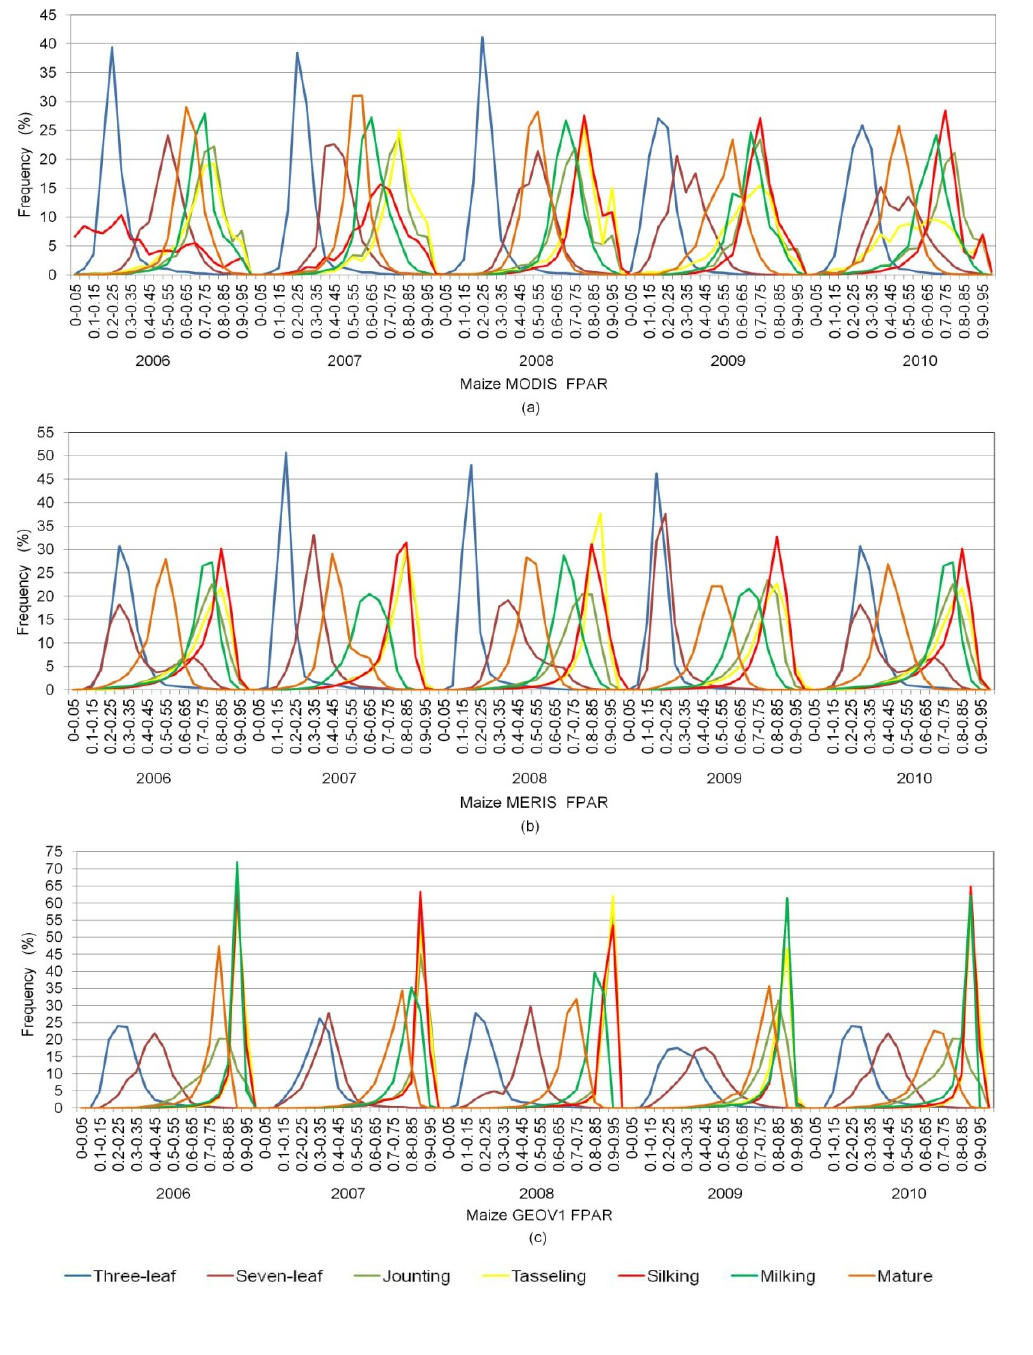
Figure 4. Maize and winter wheat FPAR frequencies of MODIS, MERIS and GEOV1 in different growth stages. ( a ) Maize MODIS FPAR; ( b ) Maize MERIS FPAR; ( c ) Maize GEOV1 FPAR; ( d ) Winter wheat MODIS FPAR; ( e ) Winter wheat MERIS FPAR; ( f ) Winter wheat GEOV1